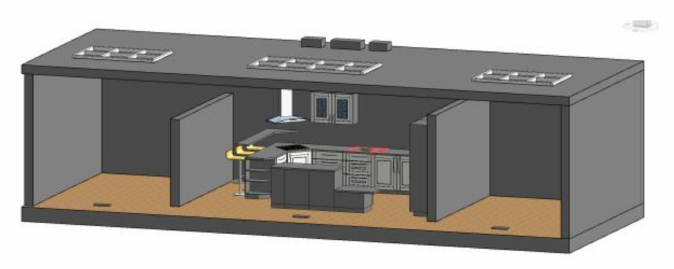
Figure 5. Three-dimensional perspective of the kitchen.